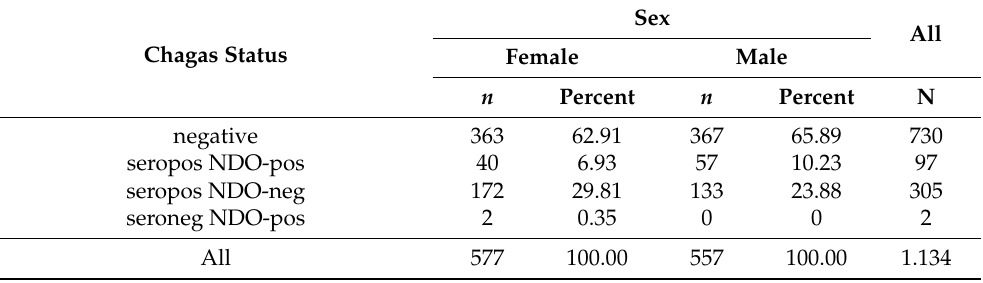
Table 2. Chagas status in the entire study population by sex ( n = 1134).